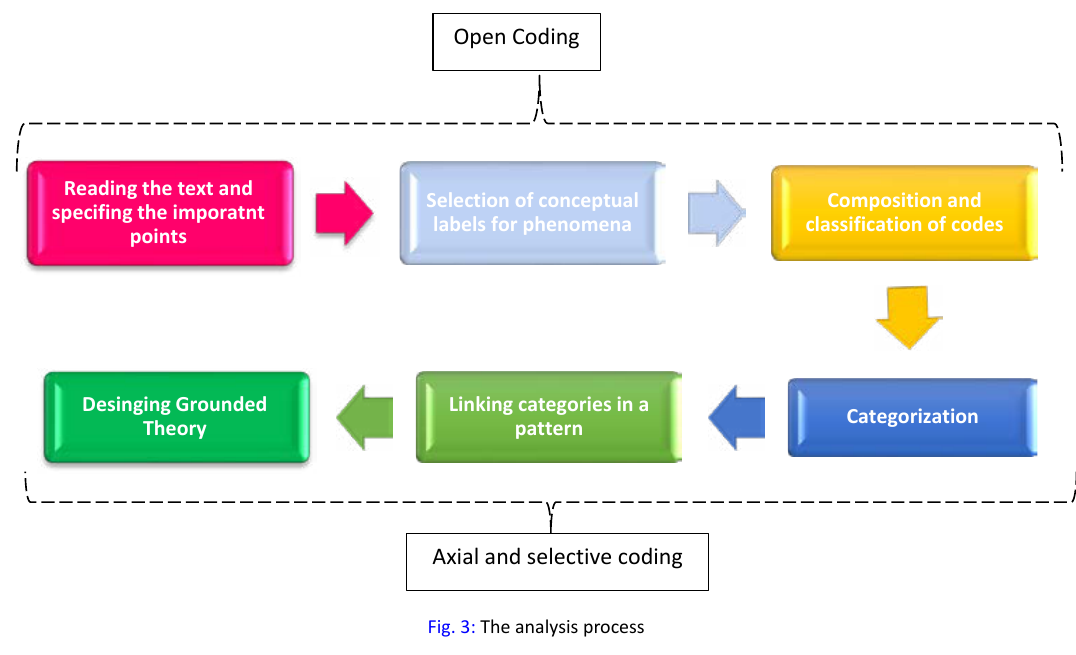
Fig. 3 : The analysis